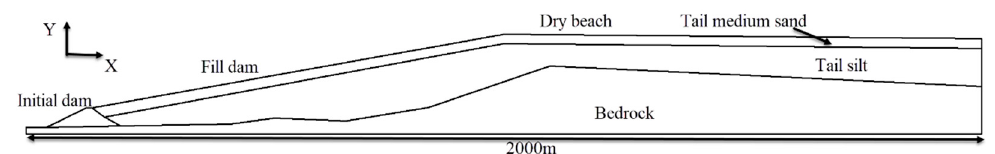
Figure 4. The 2D model in geo-studio.